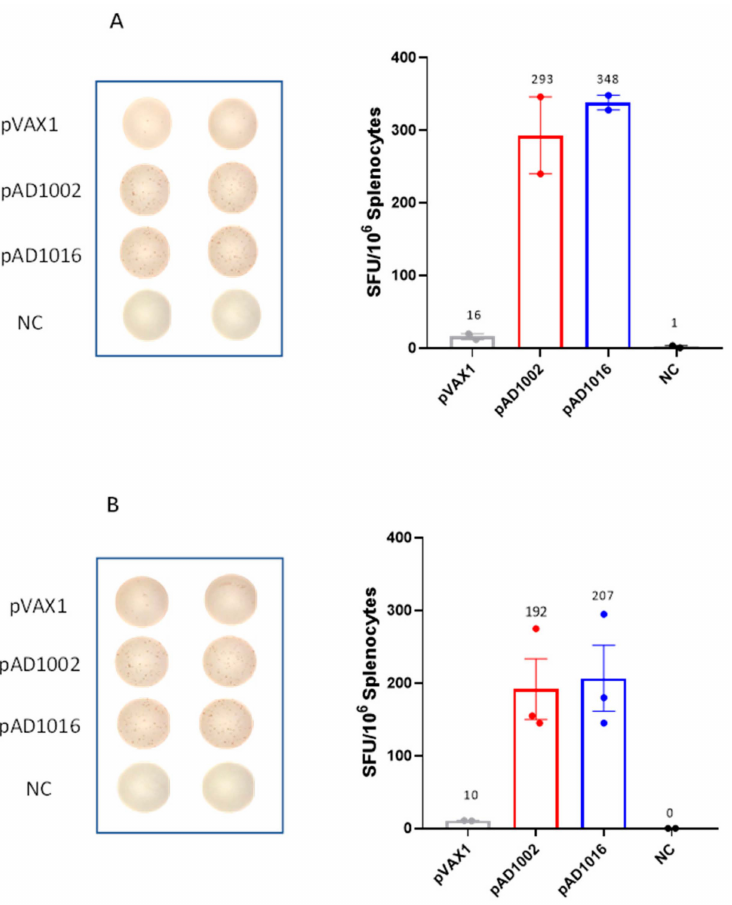
Figure 2. SARS-CoV-2-specific T cell responses in pAD1016-vaccinated mice. C57BL/6 mice were IM+EP immunized twice with pVAX1, pAD1002 or pAD1016 ( n = 5, 20 µ g/dose, fortnight interval) and then sacrificed for spleens 14 days after boost. ELISpot analyses of IFN- γ spot-forming cells (SFC) amongst splenocytes after re-stimulation with, or without (NC), pooled 14-mer overlapping peptides covering the sequences of RBD SARS ( A ) or RBD BA4/5 ( B ) were